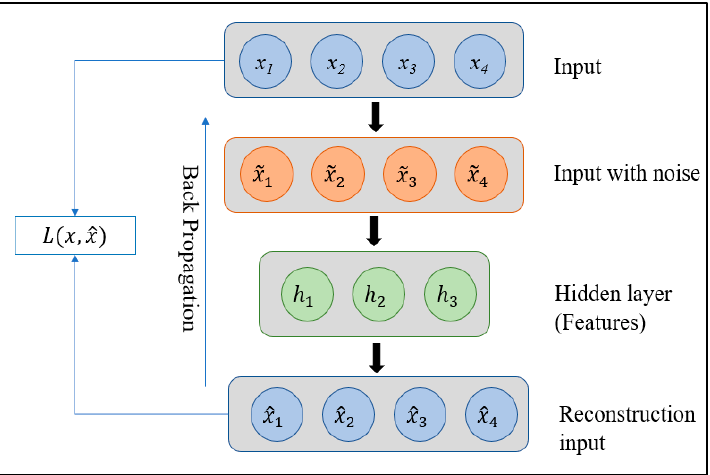
Figure 2 . Typical structure of denoising autoencoders